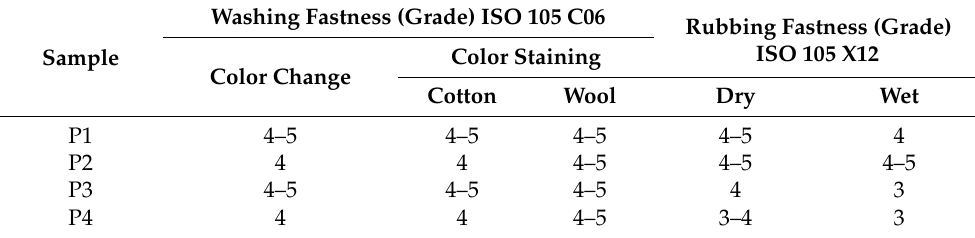
Table 4. Evaluation of coating